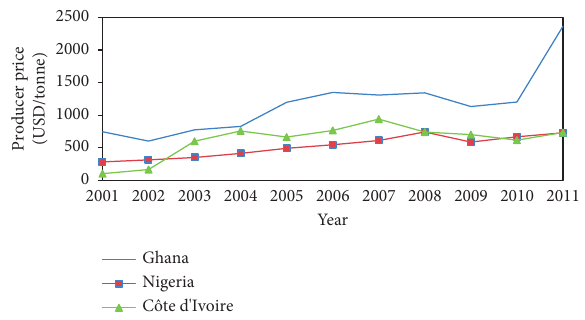
Figure 2: Comparison of kola nuts producer price (USD/tonne) between Ghana and two major world producers (2001 to 2011). Source: FAO (Food and Agricultural Organisation)